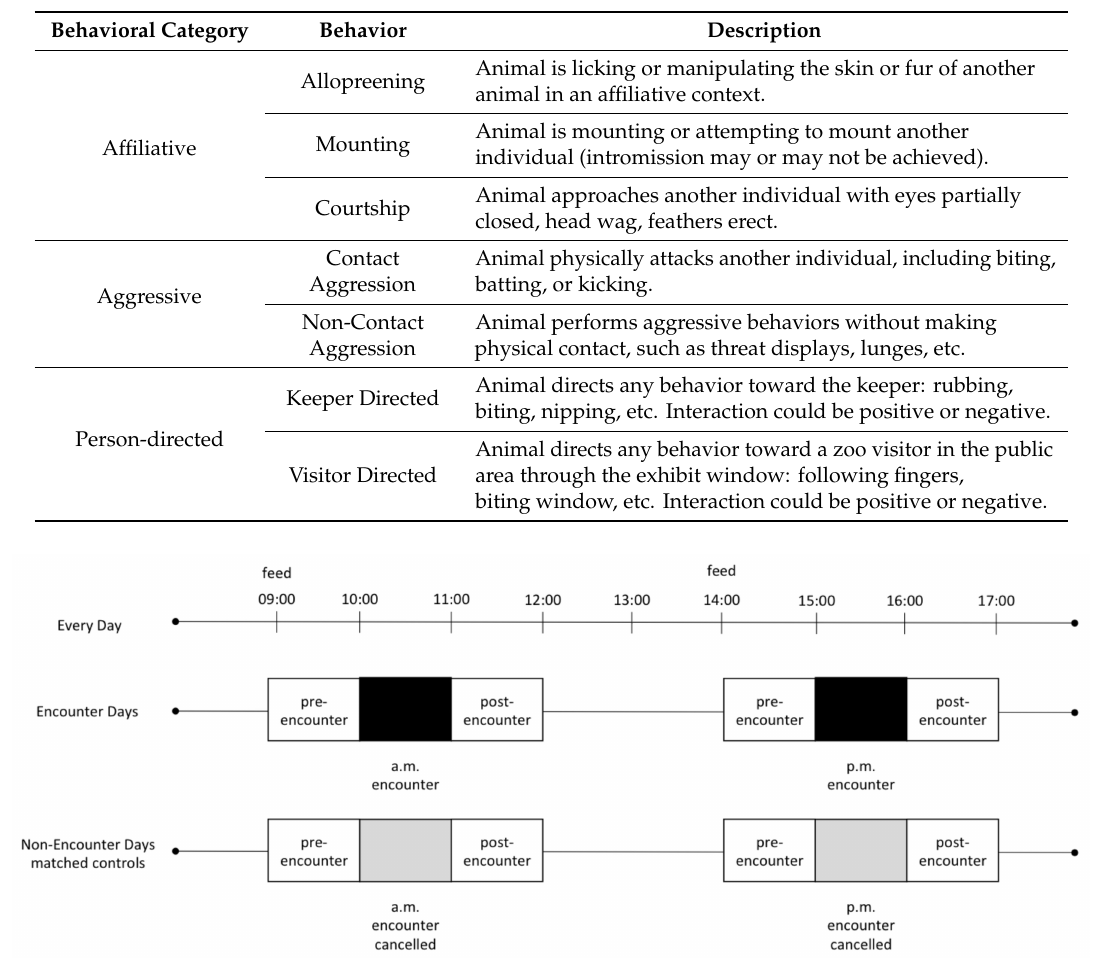
Table 1. Ethogram for data collection while encounters were not occurring.